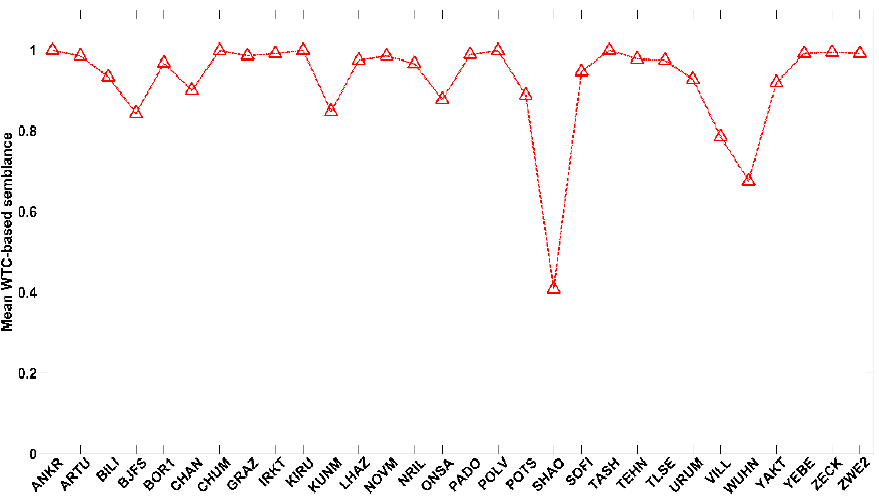
Figure 5. Mean value of the WTC-based semblance at the period closest to 1 year for 30 sites.